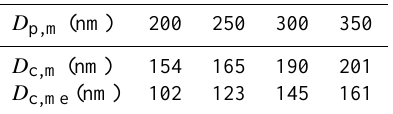
Table 1. The mobility diameter ( D c,m ) and mass-equivalent diam- eter ( D c,me ) of In-BC cores at peaks in the size distribution (Fig. 2) determined by VTDMA and SP2 of size-resolved In-BC particles of 200–350nm ( D p,m ) .